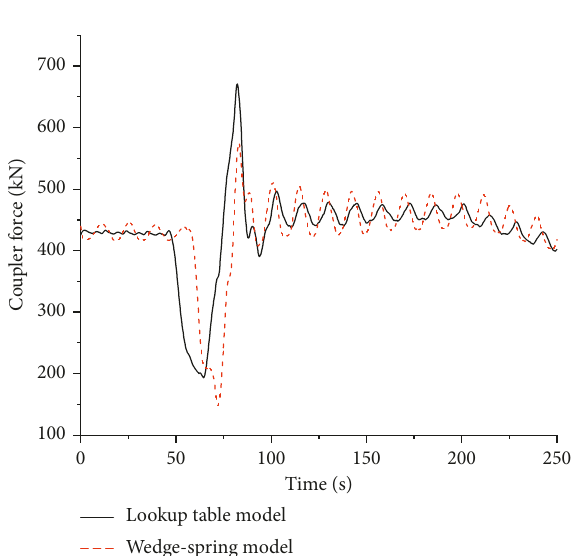
Figure 11: Time course of the coupler force of the 108th